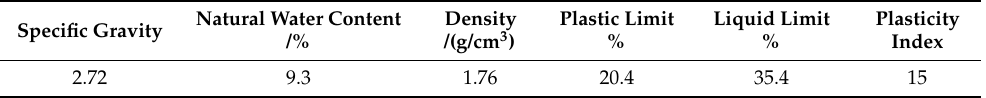
Table 1. Physical properties of test